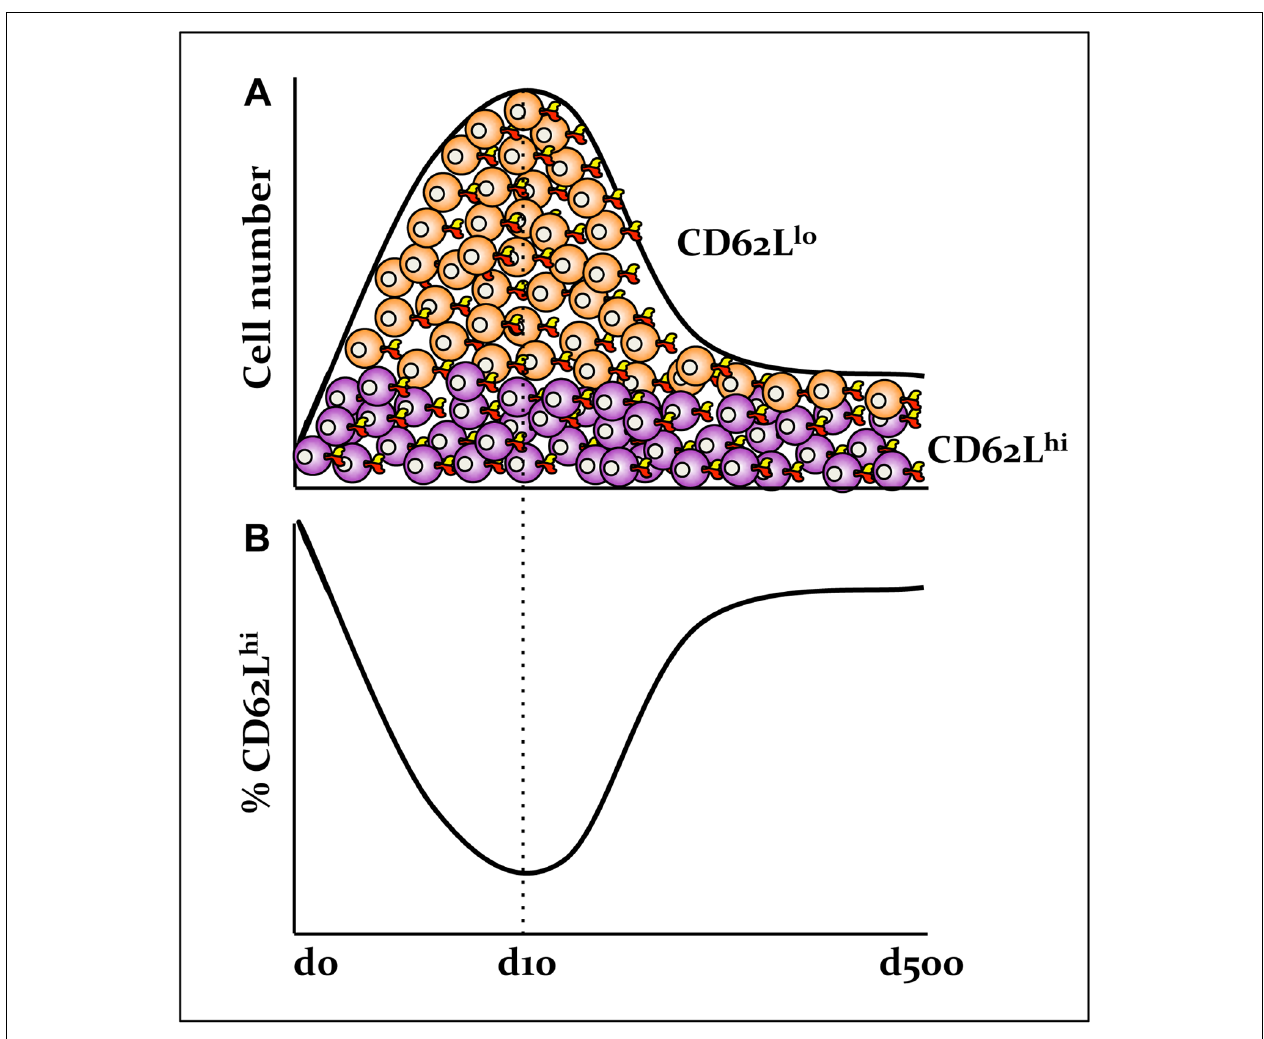
FIGURE 1 | Preferential survival of antigen-specific memory CD62L hi CD8 + T cells following influenza virus infection. (A) The numbers of influenza-specific CD62L hi CD8 + T cells, but not CD62L lo CD8 + T cell sets,